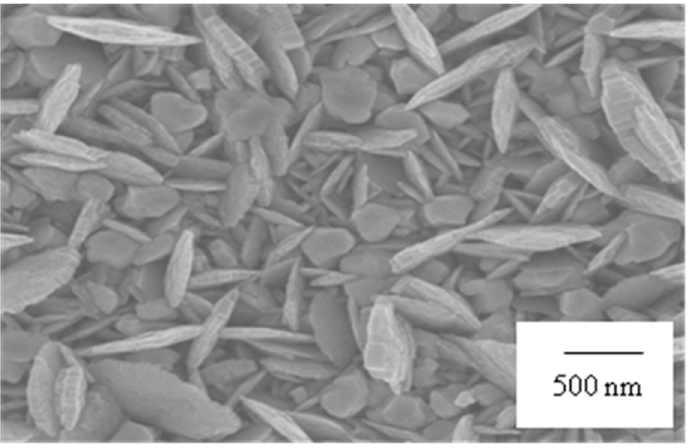
Figure 2. SEM image of Au nanostructures formed on the copper substrate after 4 min electroless plating at 85 °C.